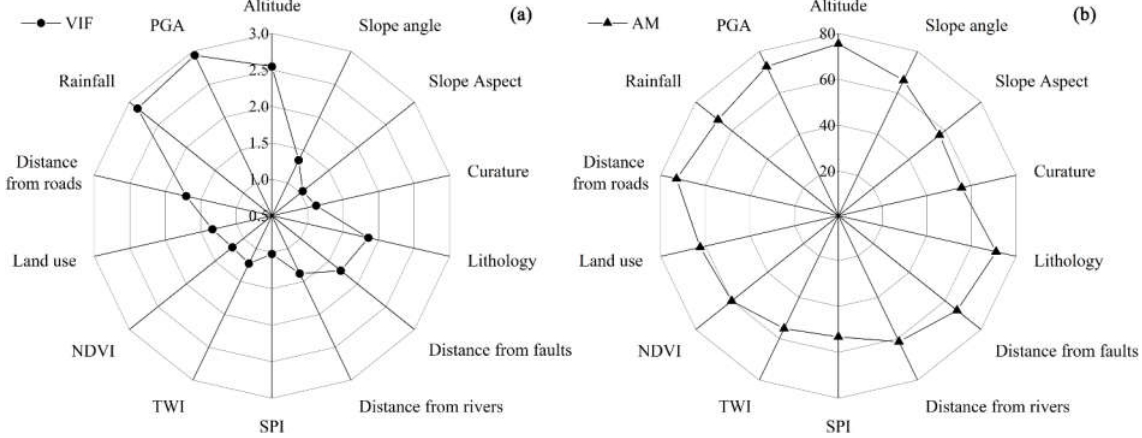
Figure 6. The VIF ( a ) and AM index ( b ) of the conditioning variables in the study